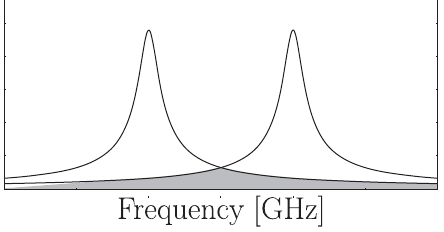
FIG. 3. An example of two modes with different frequencies which overlap due to their finite bandwidth. The shaded region is helping illustrate where two modes overlap but does not indicate the magnitude of